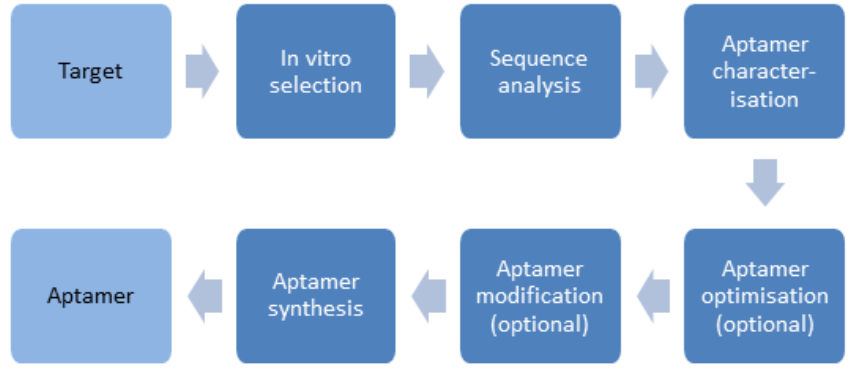
Figure 3. Schematic workflow of aptamer generation.